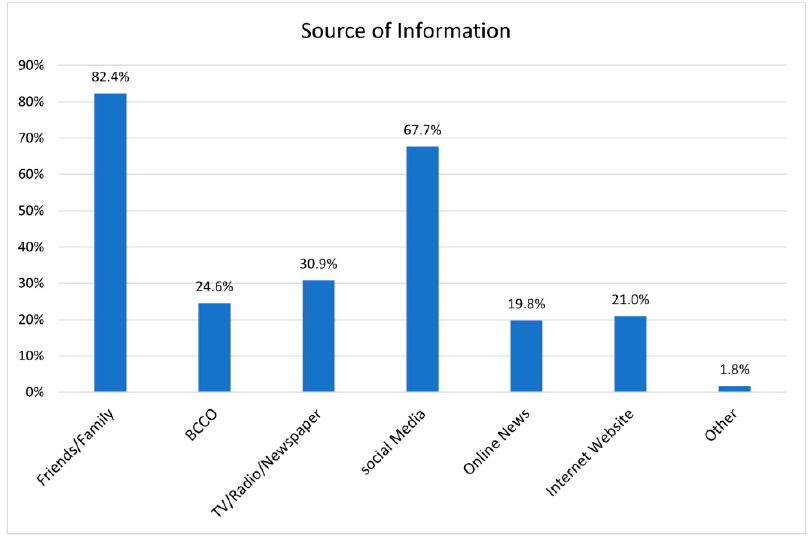
Figure 4. Source of information for participants.